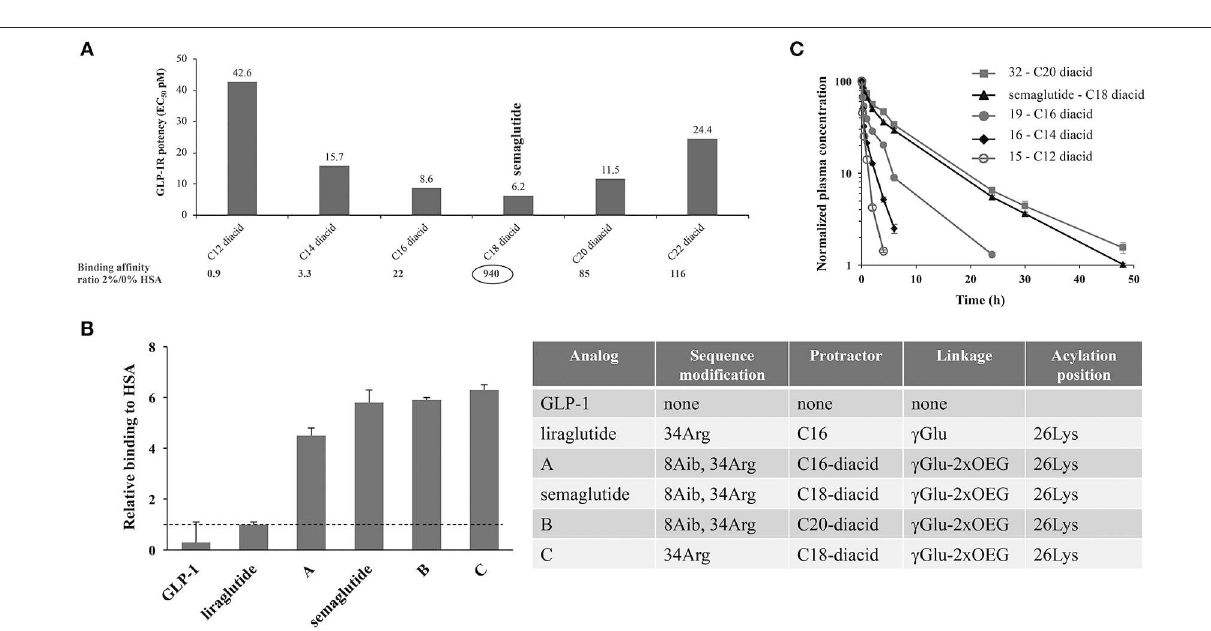
FIGURE 3 | Albumin affinity of fatty-acid derivatized peptides vs. native GLP-1. (A) Derivatives of Aib8, Arg34 GLP-1(7-37) with C12 to C22 di-acids and attached to Lys26 using γ Glu- and OEG-based linkers. GLP-1R binding at 0 and 2% HSA using baby BHK cells expressing the human GLP-1R, and in vitro potency measured in BHK cells that express both the human GLP-1R and a luciferase reporter system; (B) HSA binding of GLP-1 derivatives, assessed using analytical ultracentrifugation; (C) In vivo protraction in rats following intravenous administration of 32 (5.5 nmol/kg), semaglutide (4.2 nmol/kg), 19 (3.3 nmol/kg), 16 (5.5 nmol/kg), and 15 (5.3 nmol/kg). BHK, baby hamster kidney; EC 50 , effective concentration; GLP-1, glucagon-like peptide-1; GLP-1R, glucagon-like peptide-1 receptor; HSA, human serum albumin. Adapted with permission from Lau et al. (53). Copyright 2018, American Chemical